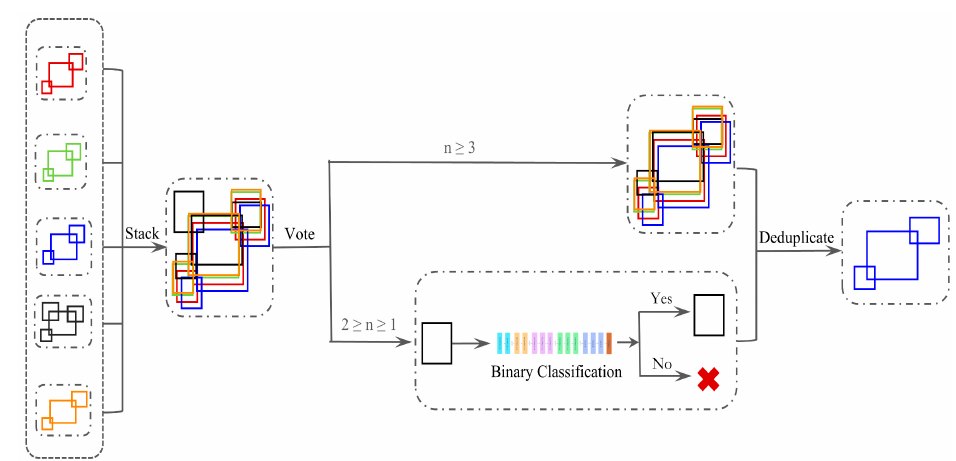
Figure 3. The processing flow of the detection boxes based on majority voting strategy.